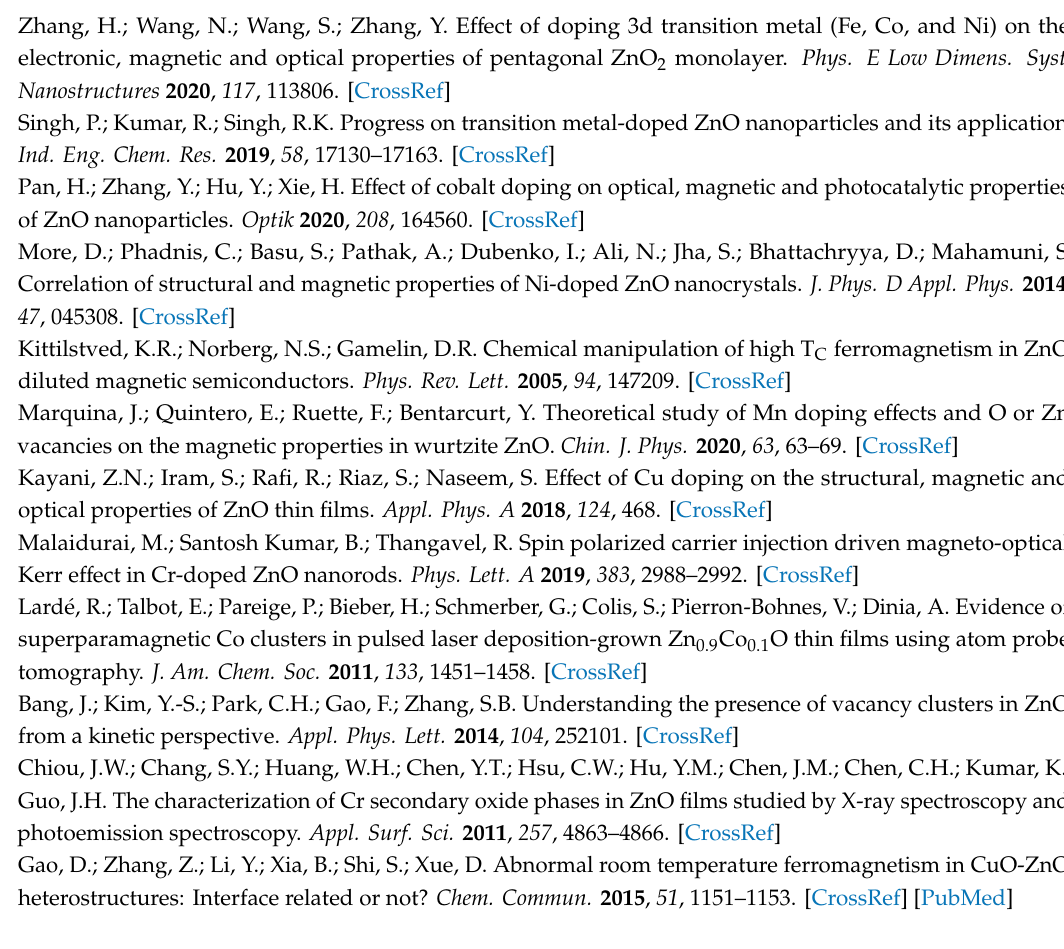
Figure S1: The M–T curves of the 0.25% Cu doped ZnO sample, Figure S2: The M–H curves of the 1.5% Cu doped ZnO sample and those after a subtraction of the diamagnetic background, Figure S3: The M–H curves of the blank sample holder and those after a subtraction of the diamagnetic background, Figure S4: The corresponding narrow-scan spectra of Cu 2 p for the 0.1%, 0.25%, 0.5% and 1% Cu doped